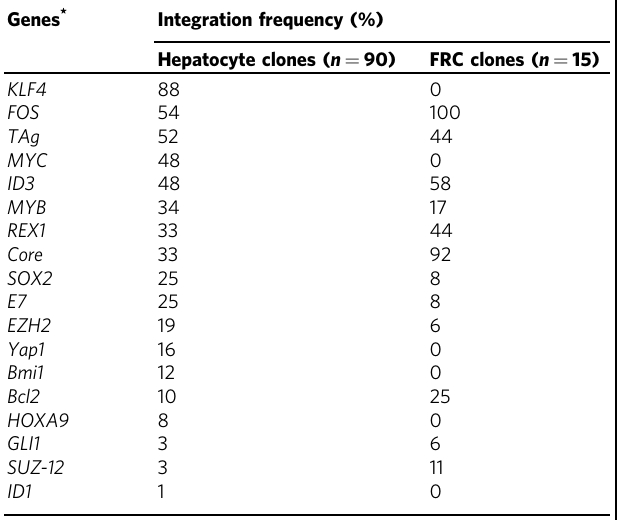
Table 2 Integration frequency of genes into hepatocyte clones and fi broblastoid reticular cell (FRC) clones Genes